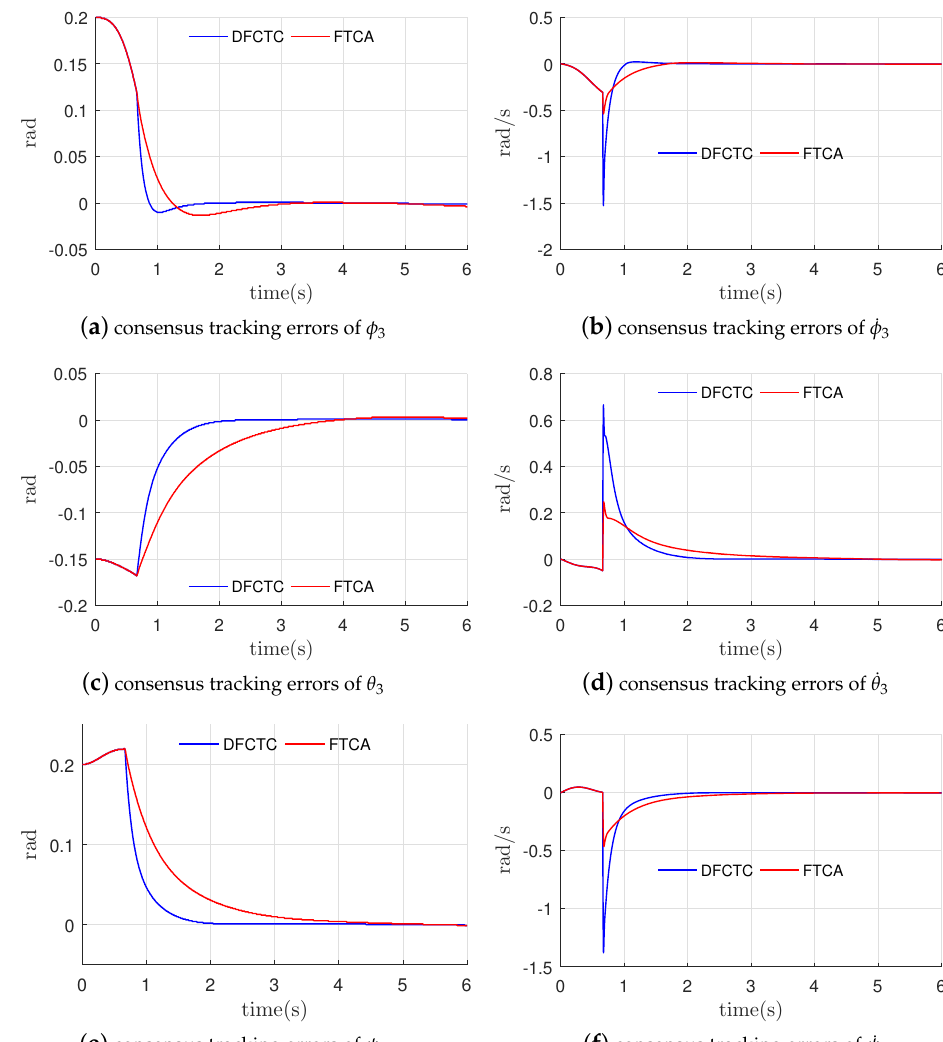
Figure 7. Consensus tracking errors for agent i =